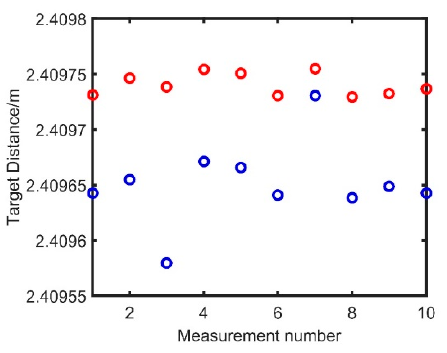
Figure 10. The results before and after the dispersion compensation.